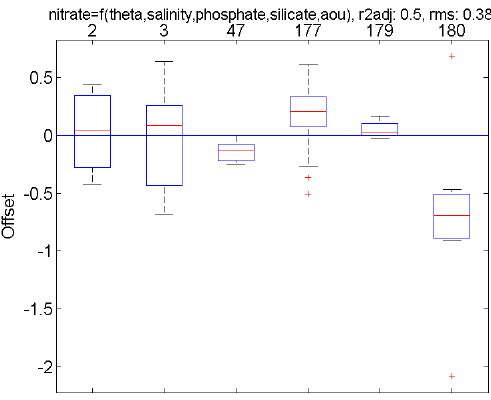
Figure 10. MLR results for NO 3 in the Makarov Basin (o ff sets in µ molkg − 1 ).